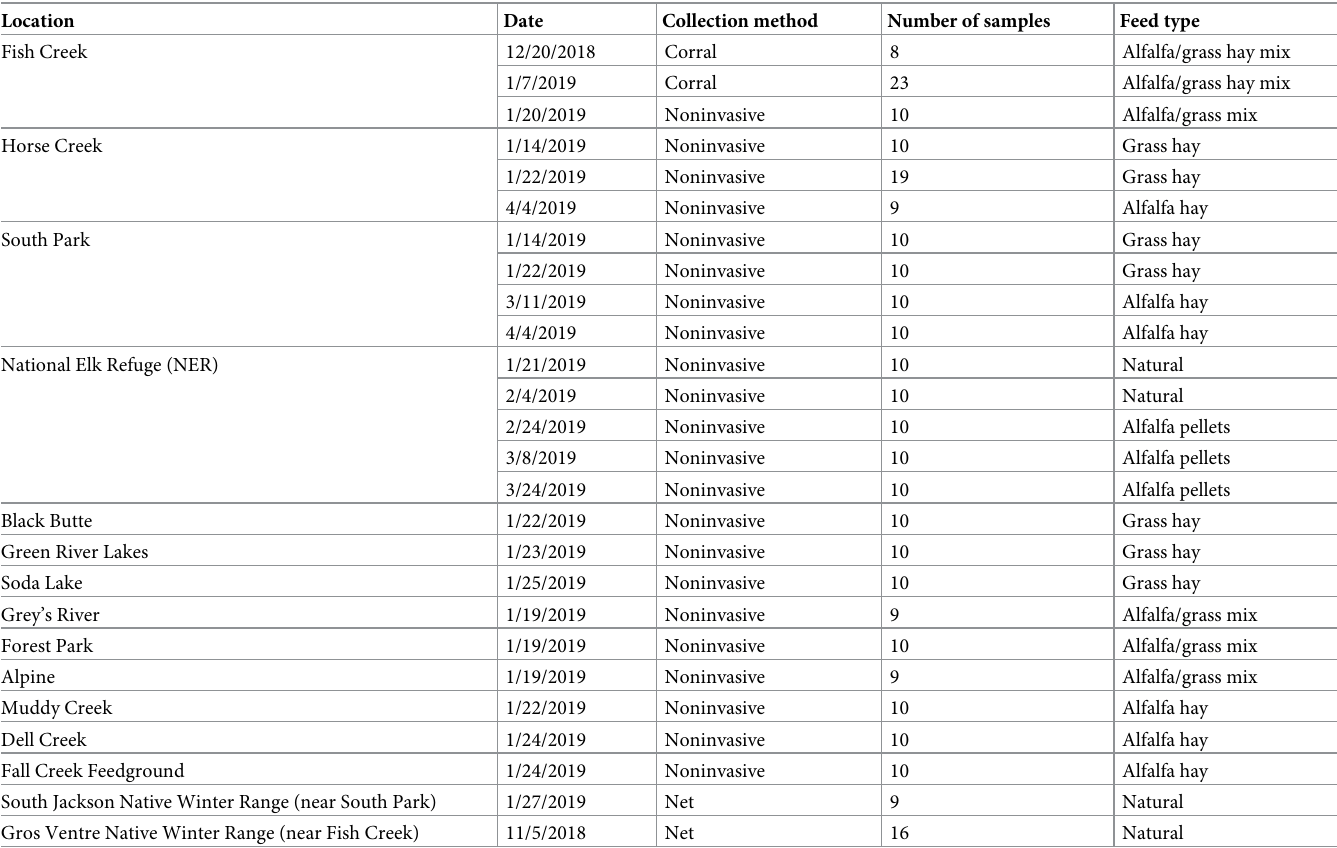
Table 1. Distribution of elk fecal samples across time, space, and sampling